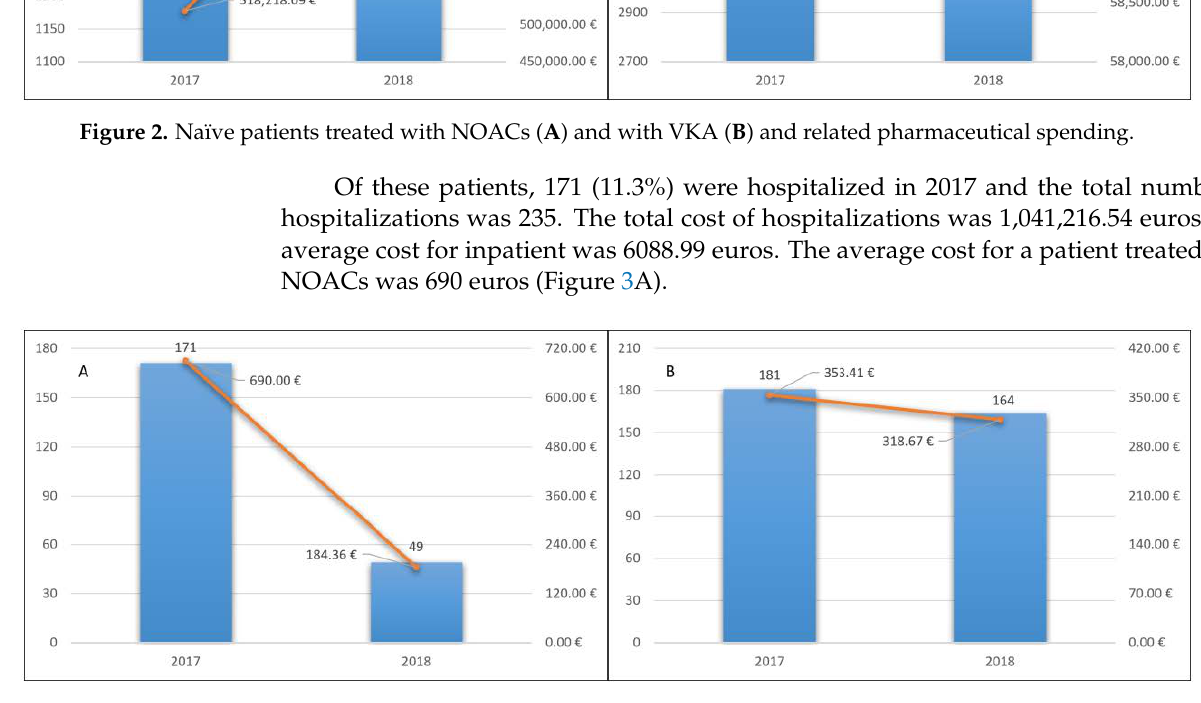
Figure 3. Hospitalization cost for a patient treated with NOACs ( A ) and VKA ( B ) and hospitalizations’